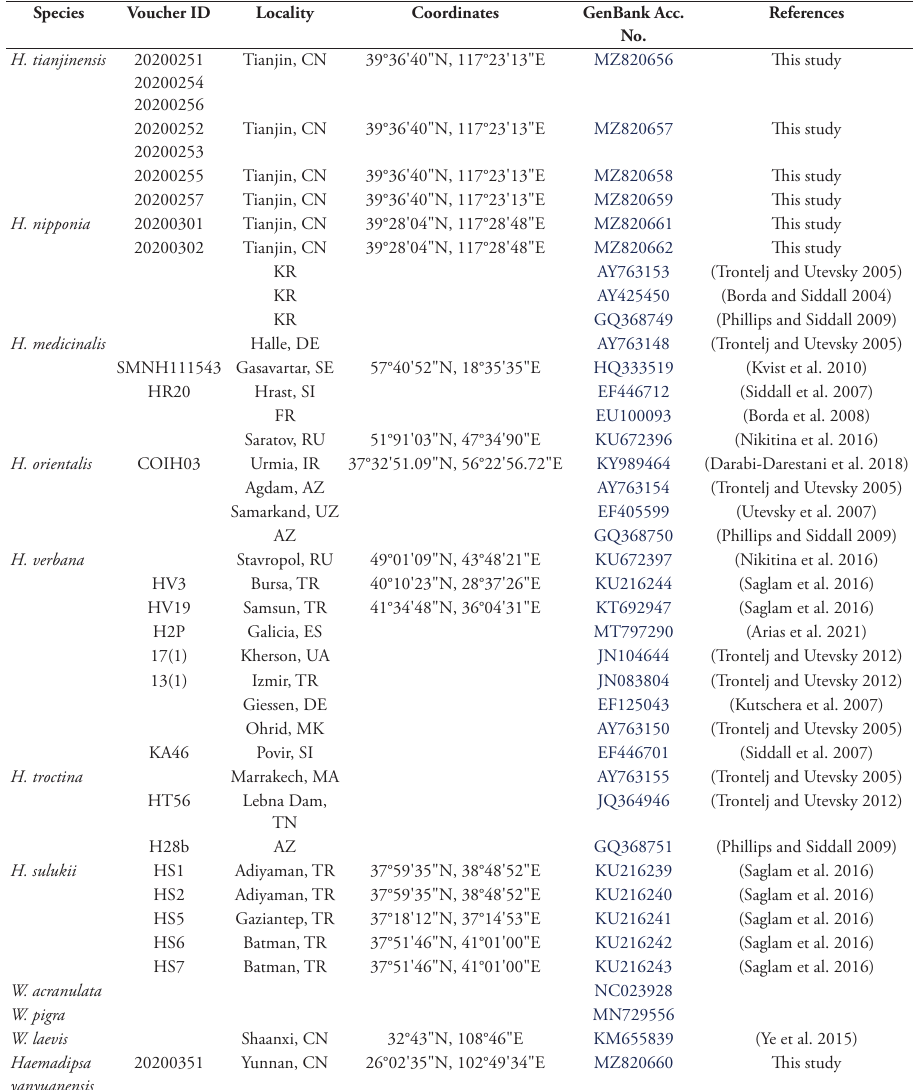
Table 1. Locality with geographic coordinates and GenBank accession numbers of specimens for phylo- genetic